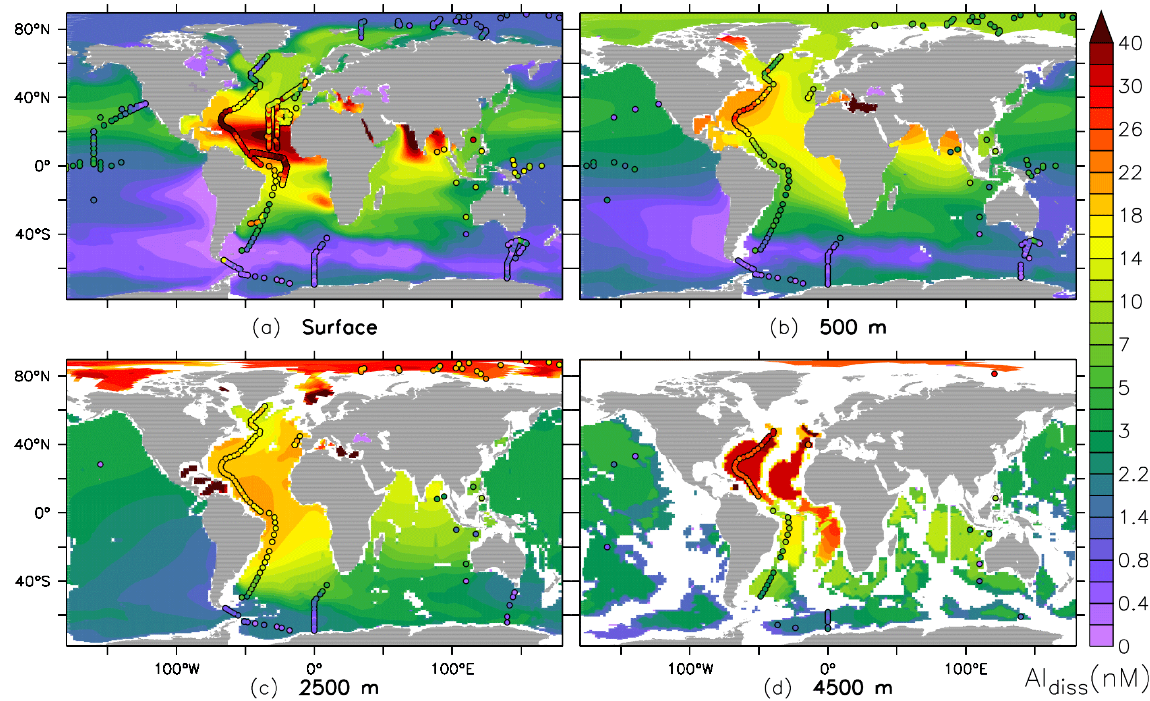
Figure 8. [ Al diss ] (nM) of the [ Si diss ] -dependent simulation with sediment resuspension (SedMackin) at four depths (500 yr after forking).